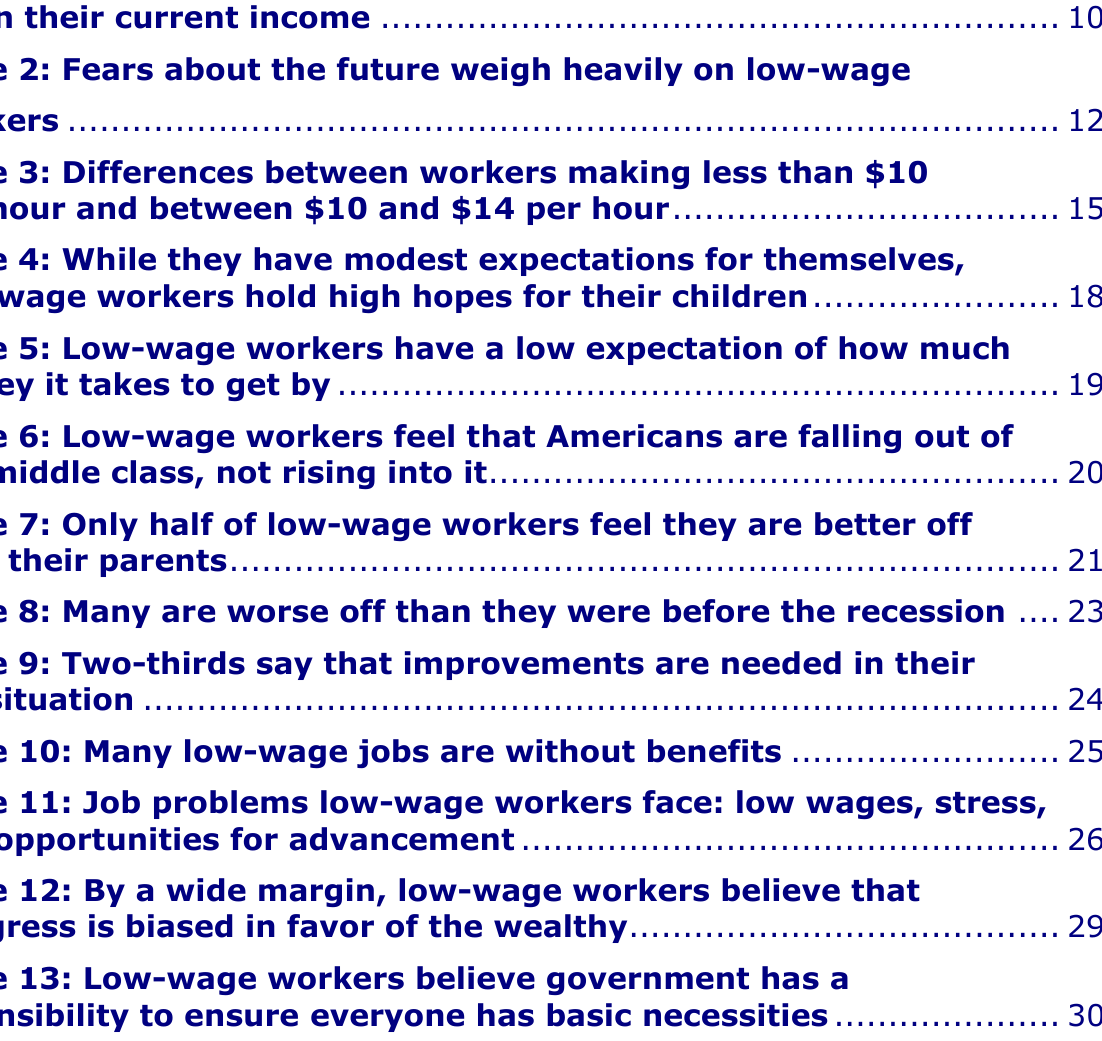
Figure 1: The majority of low-wage workers are barely scraping by on their current income ............................................................... 10 Figure 2: Fears about the future weigh heavily on low-wage workers ............................................................................................ 12 Figure 3: Differences between workers making less than $10 per hour and between $10 and $14 per hour .................................... 15 Figure 4: While they have modest expectations for themselves, low-wage workers hold high hopes for their children ....................... 18 Figure 5: Low-wage workers have a low expectation of how much money it takes to get by ................................................................... 19 Figure 6: Low-wage workers feel that Americans are falling out of the middle class, not rising into it ..................................................... 20 Figure 7: Only half of low-wage workers feel they are better off than their parents ............................................................................. 21 Figure 8: Many are worse off than they were before the recession .... 23 Figure 9: Two-thirds say that improvements are needed in their job situation ..................................................................................... 24 Figure 10: Many low-wage jobs are without benefits ......................... 25 Figure 11: Job problems low-wage workers face: low wages, stress, few opportunities for advancement .................................................. 26 Figure 12: By a wide margin, low-wage workers believe that Congress is biased in favor of the wealthy ........................................ 29 Figure 13: Low-wage workers believe government has